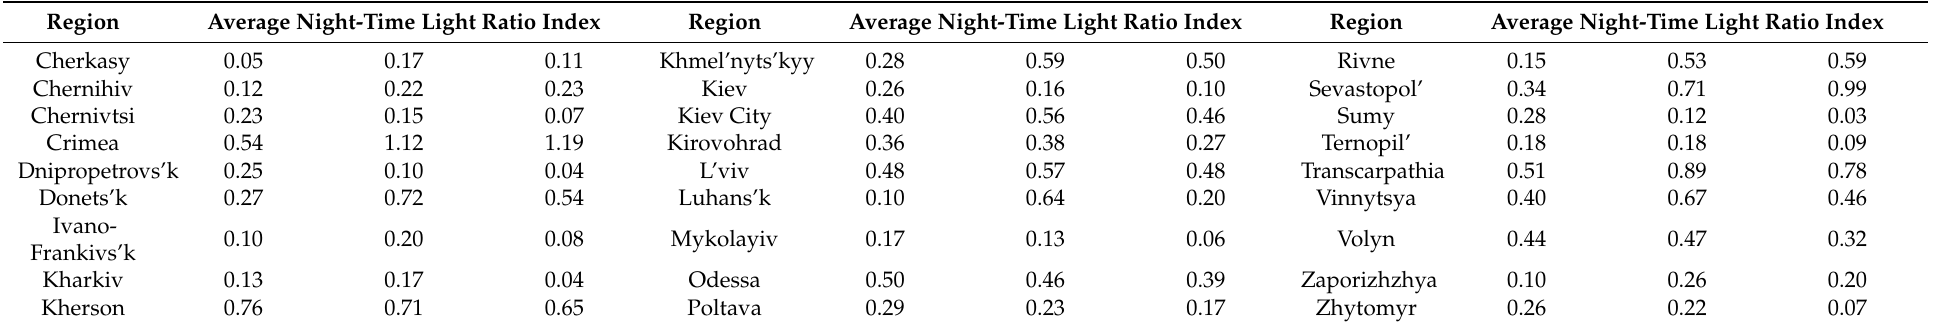
Table 2. The average luminous ratio of each region in the three time periods (2.24–2.28, 3.1–3.18,